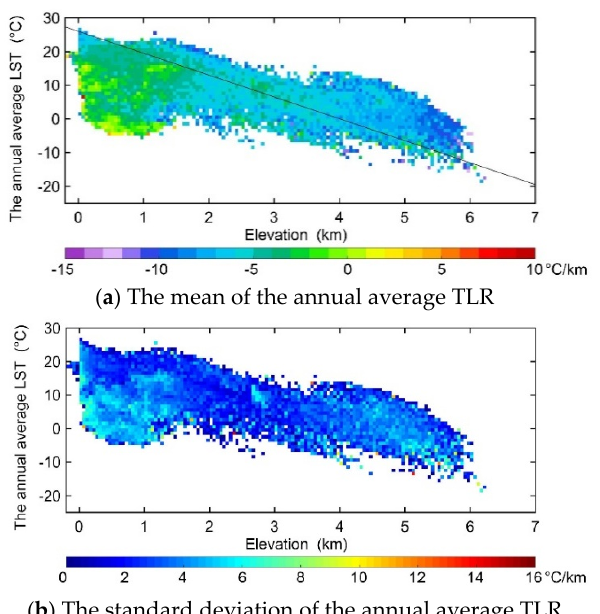
Figure 9. The relationship of the mean ( a ) and standard deviation ( b ) of the annual average TLR with elevation and the annual average LST. The spacing of elevation was 50 m and that of LST was 1 °C. The value of a grid in patch a ( b ) was the mean (standard deviation) of the TLRs of the image pixels, where TLRs ranged within the grid bound. If the number of above-mentioned image pixels was less than two, the value was assigned as null. The slope of the solid line in patch ( a ) represents a reference TLR of − 6.5 °C/km. The color bar in patch ( a ) is the same as that in Figure 8.